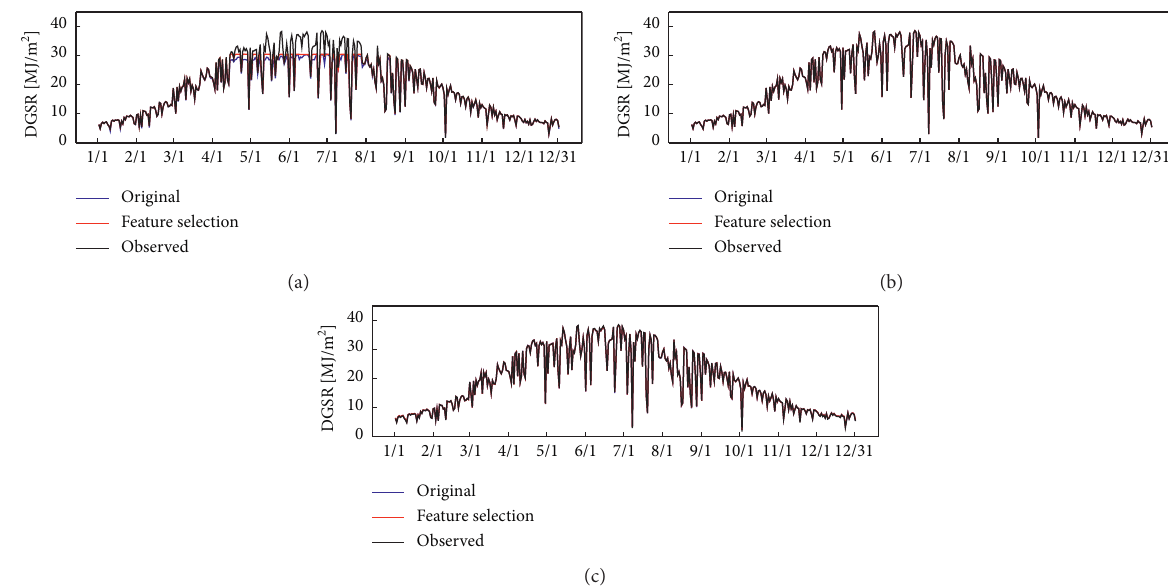
Figure 6: Fitting curve plot between measured and predicted